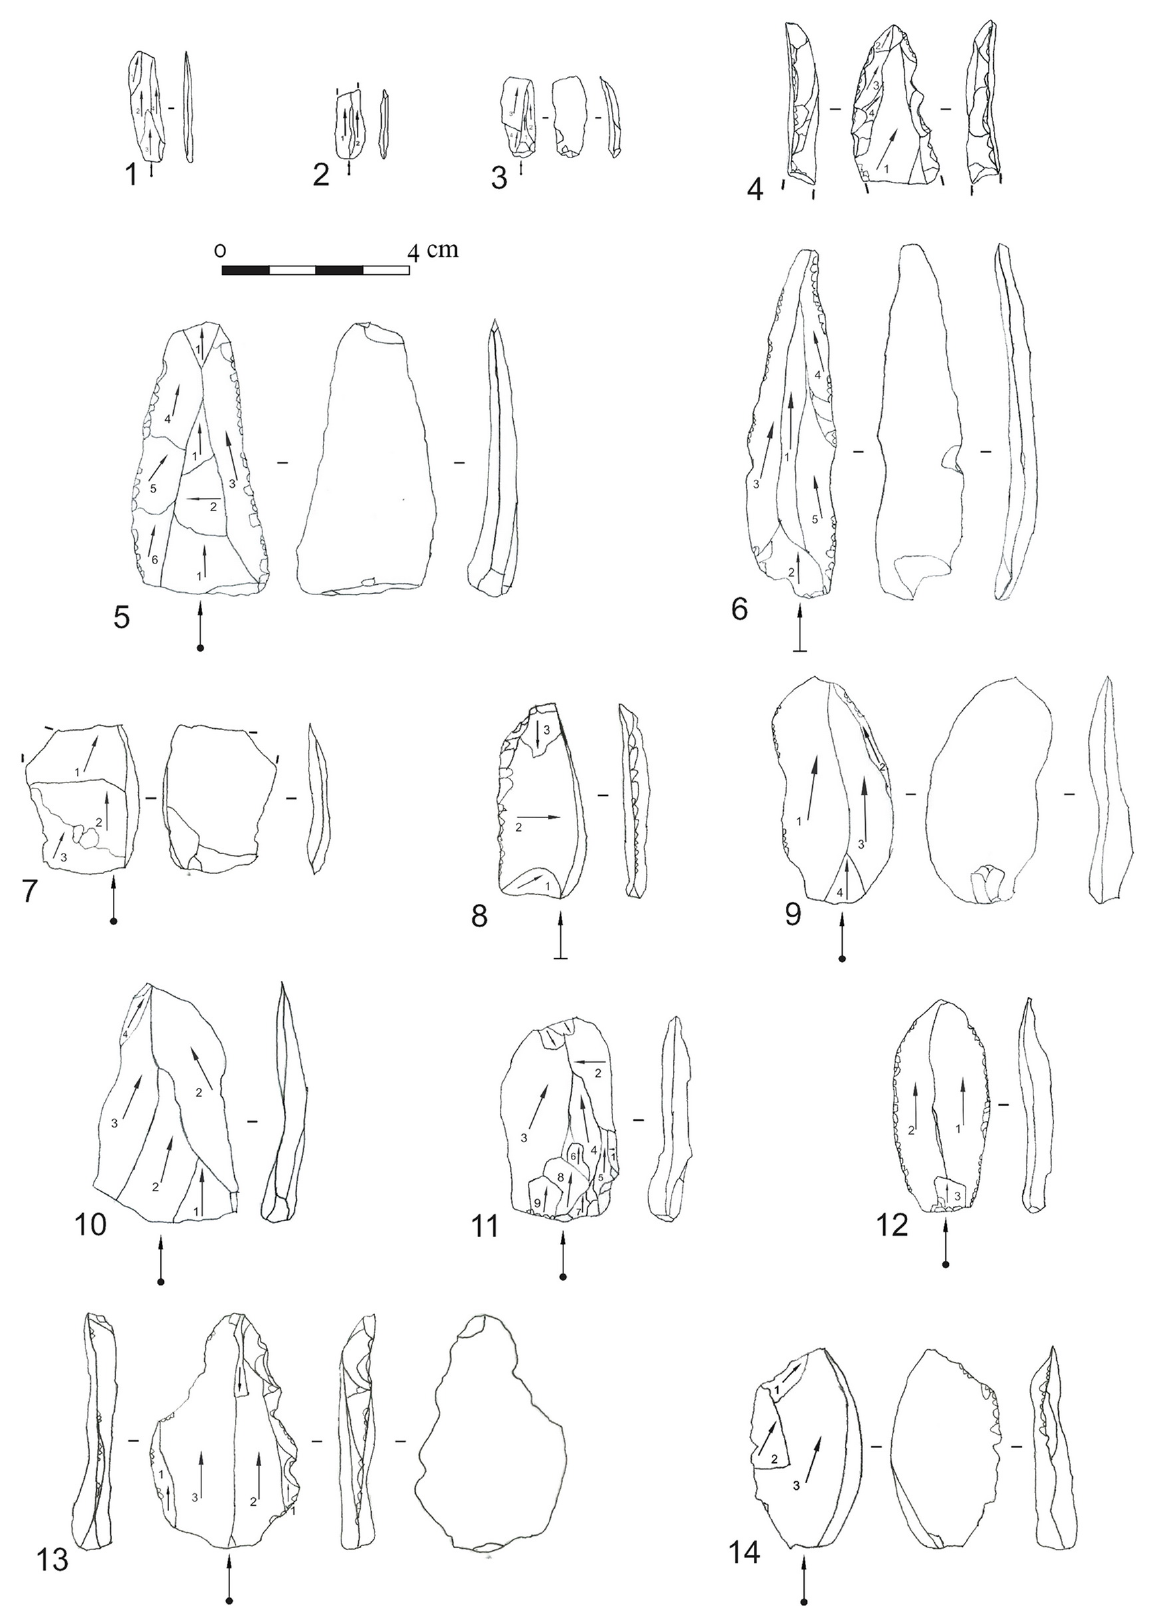
Figure 4. Drawing of target flakes and retouched tools. 1, 2, 3: bladelets, target objective of volumetric production; 4: retouched tool: denticulate point; 5, 6, 10: convergent flakes target objective of Levallois production; 7, 8, 14: backed flakes, target objective of Levallois production; 9,11,12: flakes, target objective of Levallois production; 13: retouched tool: denticulate